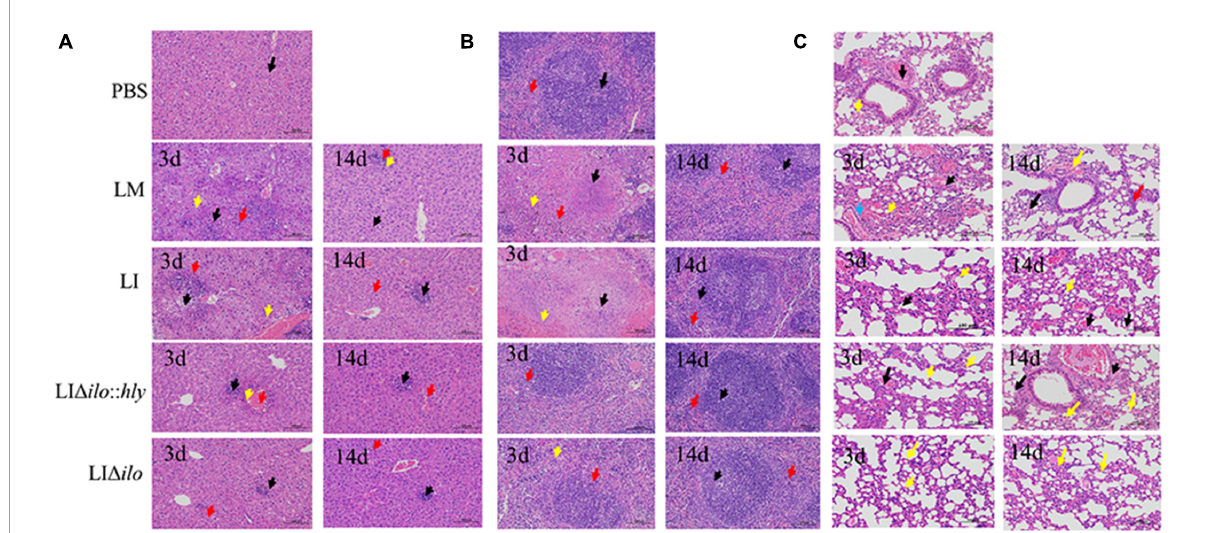
FIGURE5 Pathological changes of mouse organs. Pathological changes of Liver (A) , spleen (B) , and lung (C) after inoculation of each strain (200 × ). The arrows in panel (A) indicated the lesions as below: ballooning or cytoplasmic vacuolation (black arrows); small foci of necrosis (yellow arrows), and inflammatory cell infiltration (red arrows); The arrows in panel (B) indicated the lesions as below: central expansion of the white pulp or pyknotic fragmentation (black arrows); extensive hemorrhage or multinucleated giant cells (yellow arrows), and inflammatory cell infiltration (red arrows); The arrows in panel (C) indicated the lesions as below: minor hemorrhage in the alveolar space (blue arrow); central dilation of the white pulp or pyknosis and fragmentation (black arrow); small hemorrhage (red arrow), and inflammatory cell infiltration (yellow